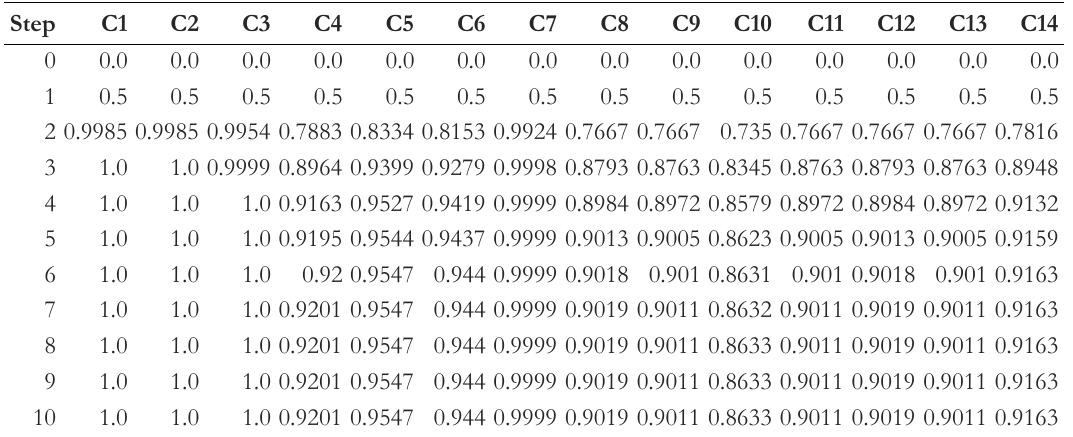
Table 5. The personal and social